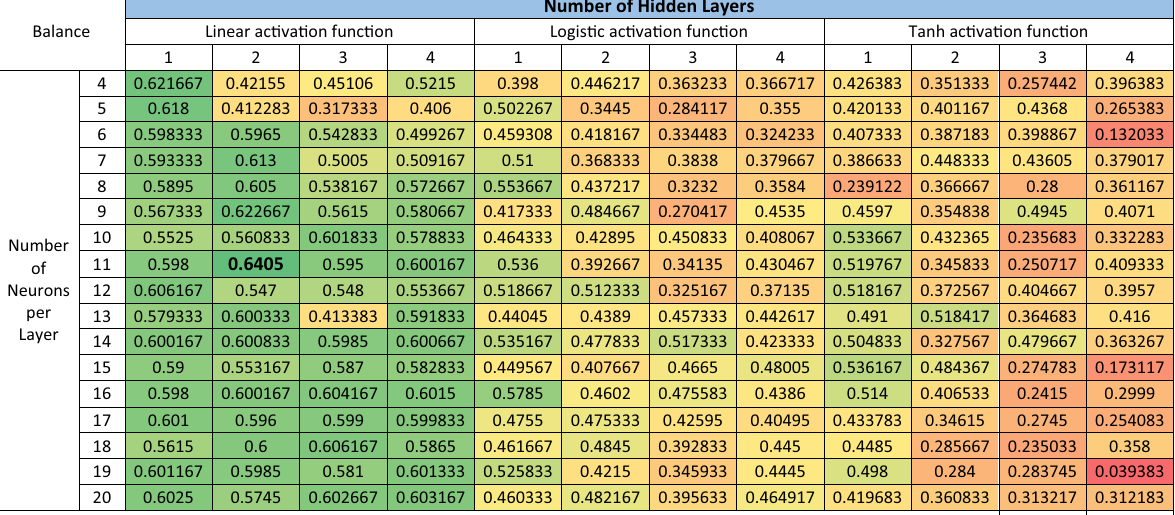
Number of Hidden Layers